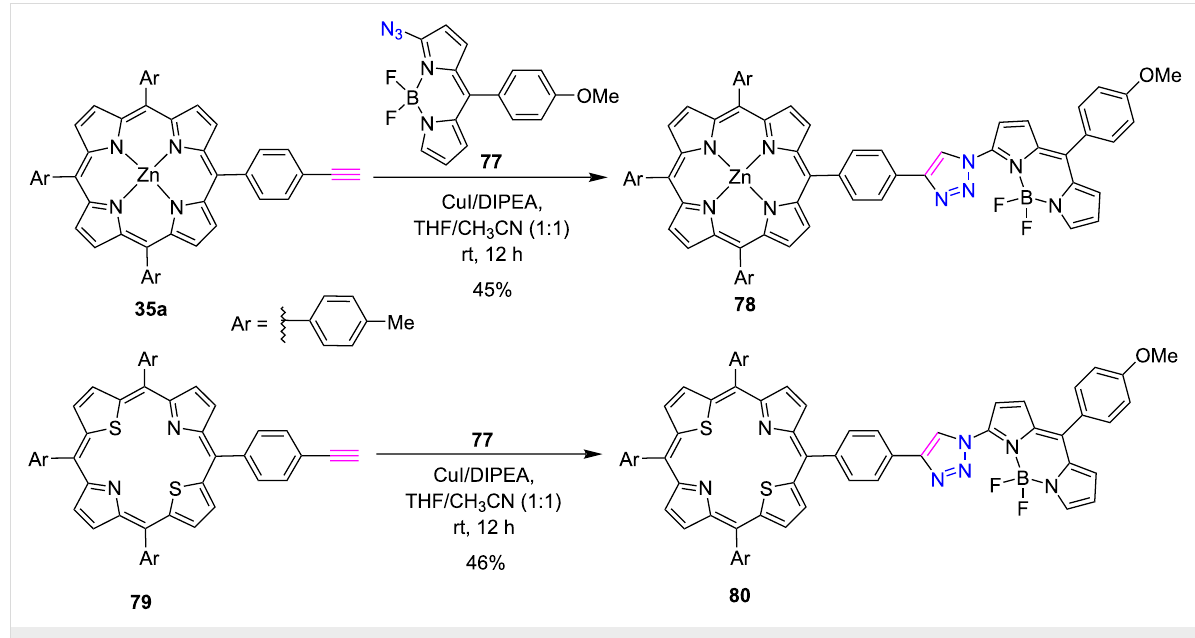
Scheme 16: Synthesis of meso - triazole-bridged porphyrin-BODIPY conjugates 78 and 80 .